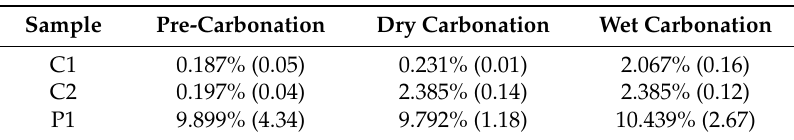
Table 2. Total inorganic carbon (TIC) results of bottom ash, expressed as an elemental percentage. Standard deviation is shown in a parenthesis.